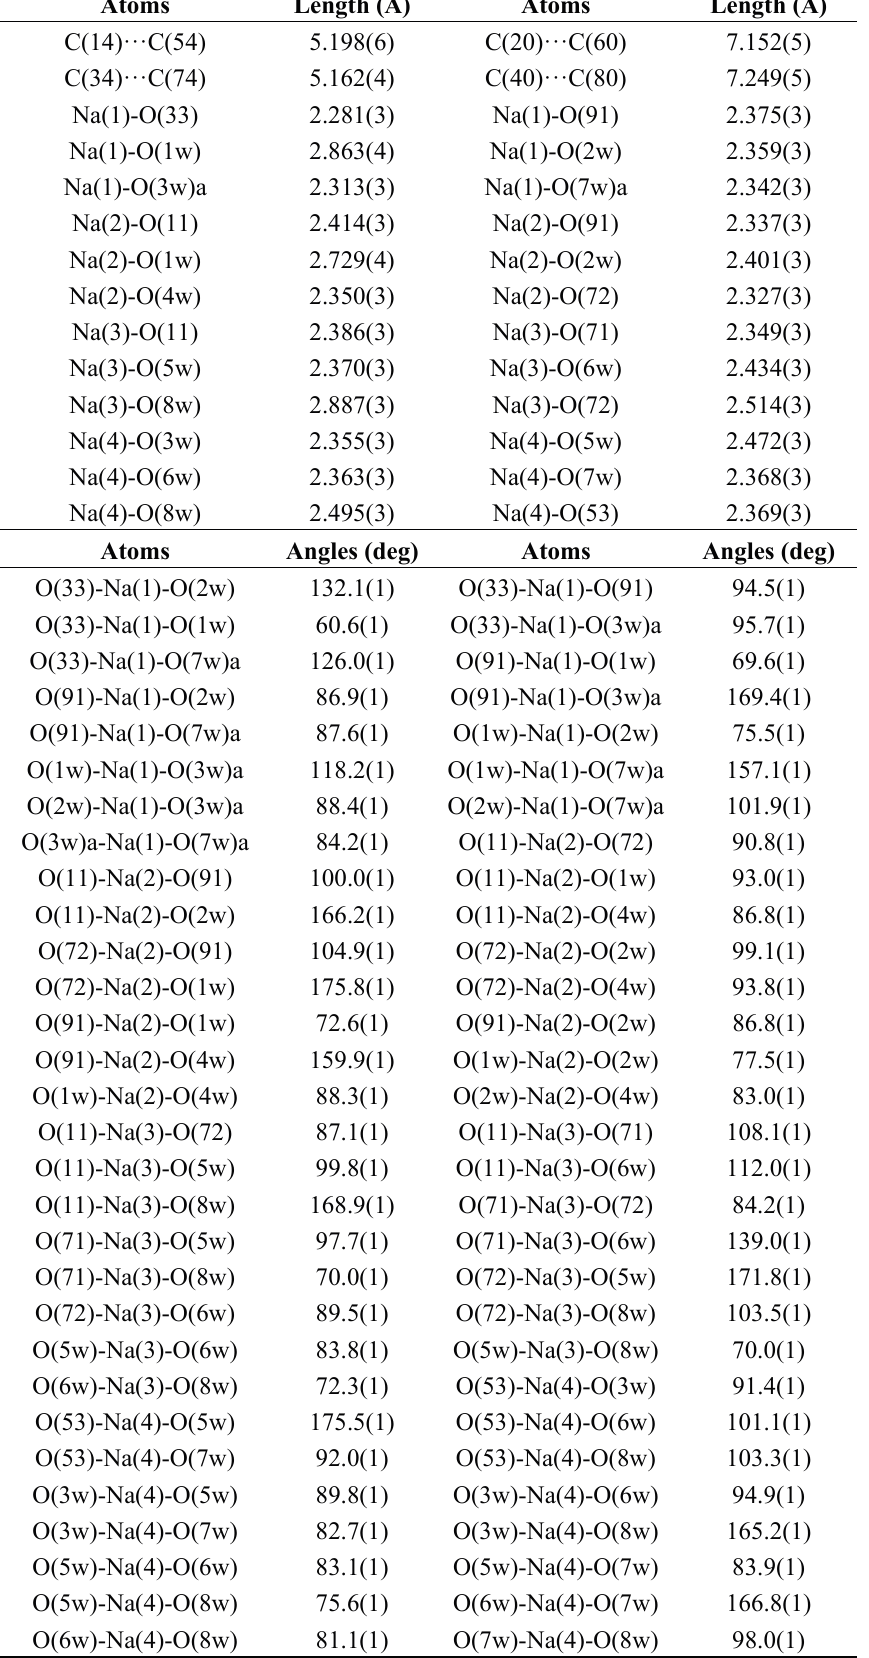
Table 2. Selected lengths and angles for 2a